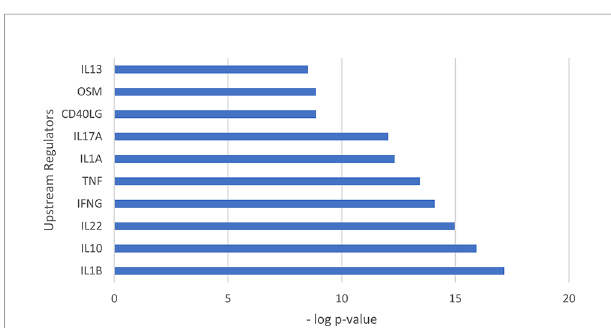
FIGURE 4 | Upstream regulation of genes encoding antimicrobial peptides identi fi ed in LCs. Bar graph showing the top 10 upstream regulators ranked by p value. The top upstream regulator was IL1B (p= 7.07x10